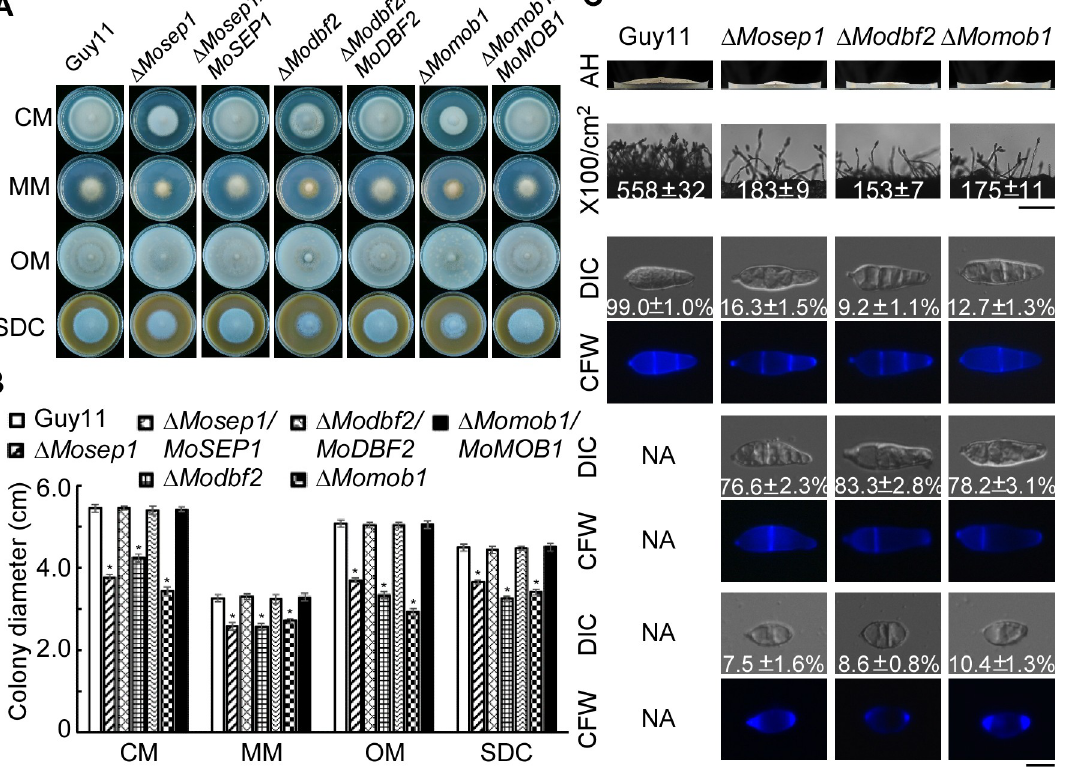
Fig 3. MEN components MoSep1, MoDbf2, and MoMob1 are involved in vegetative growth and conidiation of M . oryzae . (A) The Δ Mosep1 , Δ Modbf2 , and Δ Momob1 mutants displayed significantly reduced mycelial growth on complete media (CM), minimal media (MM), oatmeal media (OM), and straw decoction and corn media (SDC) after incubation at 28˚C for 7 days in darkness. (B) Statistical analysis of colony diameters from Guy11, Δ Mosep1 , Δ Modbf2 , and Δ Momob1 mutants, and their corresponding complemented strains on different media. Error bars represent standard deviations from three independent experiments. Asterisks indicate statistical significance according to a Student’s test (p < 0.01). (C) The first line shows aerial hyphae (AH) growth was reduced in the Δ Mosep1 , Δ Modbf2 , and Δ Momob1 mutants after incubation for 10 days. The second line shows conidia formation under a light microscope 24 h at room temperature after induction of conidiation under coverslips. Bar, 50 μ m. The bottom line shows conidia of Guy11, the Δ Mosep1 , Δ Modbf2 , and Δ Momob1 mutants examined by differential interference contrast (DIC) and epifluorescence microscopy, respectively. NA, not available. Bar, 10 μ